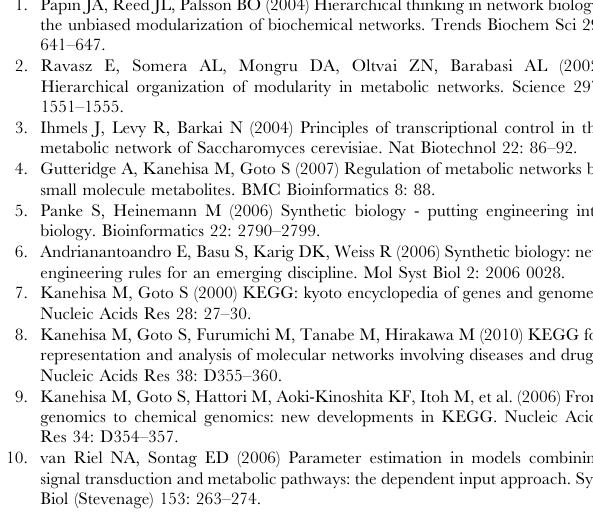
Figure S2 Network of terminal modules from the partitioning of the hepatocyte metabolic network based on both Newman’s connectivity metric (A) and ShReD (B). The interactions between modules represent interactions between reactions in the respective modules. The size of a module is proportional to the number of reactions in the module. Figure S3 ShReD based partitioning of Hepatonet1 model. Boxes highlight modules centered on NADH (module ID: 253956) and NADPH (module ID: 254789) consumption and production. (carbon) reactants but different cofactors. For example, malate oxidation in the mitochondria (r0057) is in the NADH module, whereas malate oxidation in the cytosol (r0058) is in the NADPH